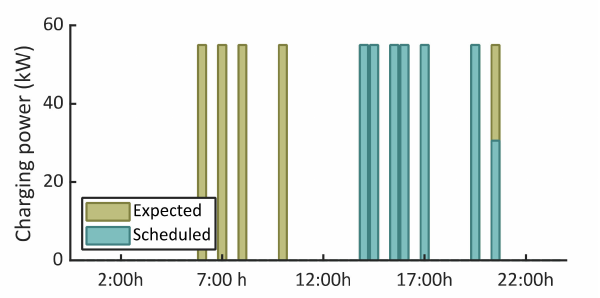
Figure 12. Expected and actual satisfied EV demand without considering flexibility (model 2).